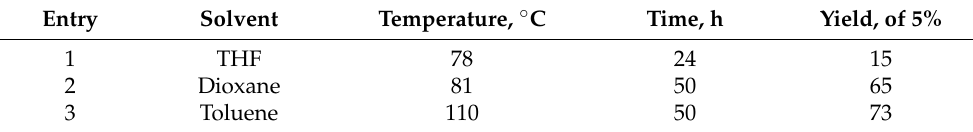
Scheme 1. Synthesis of tert -butyl bis(4 (cid:48) -(hexyloxy)-[1,1 (cid:48) -biphenyl]-4-yl)carbamate 5 . Table 1. Reaction of tert -butyl bis (4-bromophenyl) carbamate 4 with boronic acid 2 .